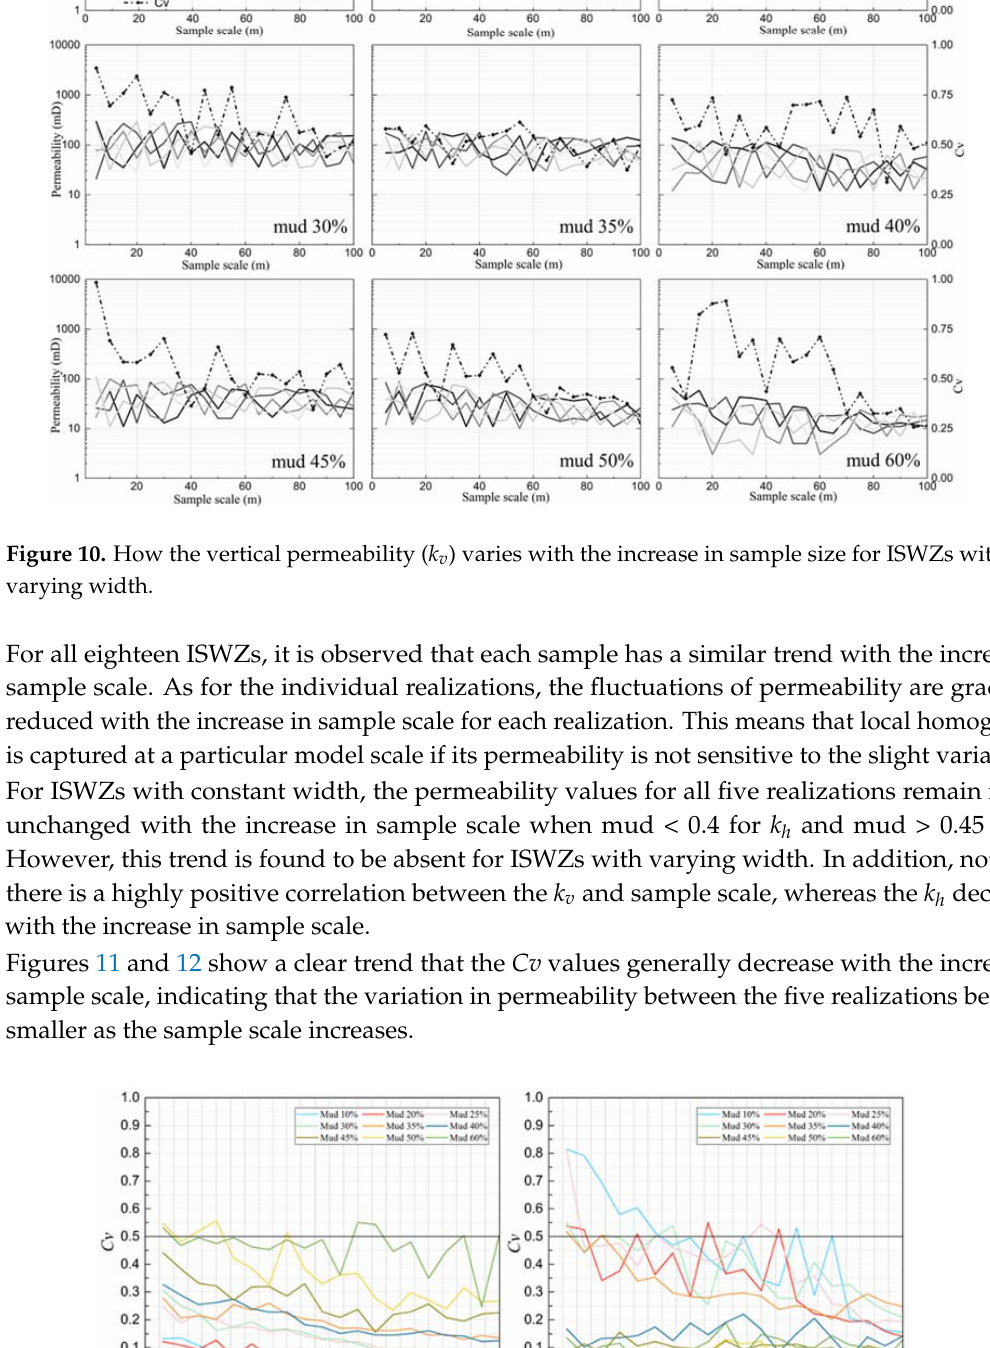
Figure 11. Cv curves for ISWZs with constant width: vertical permeability ( right ) and horizontal permeability ( left ).